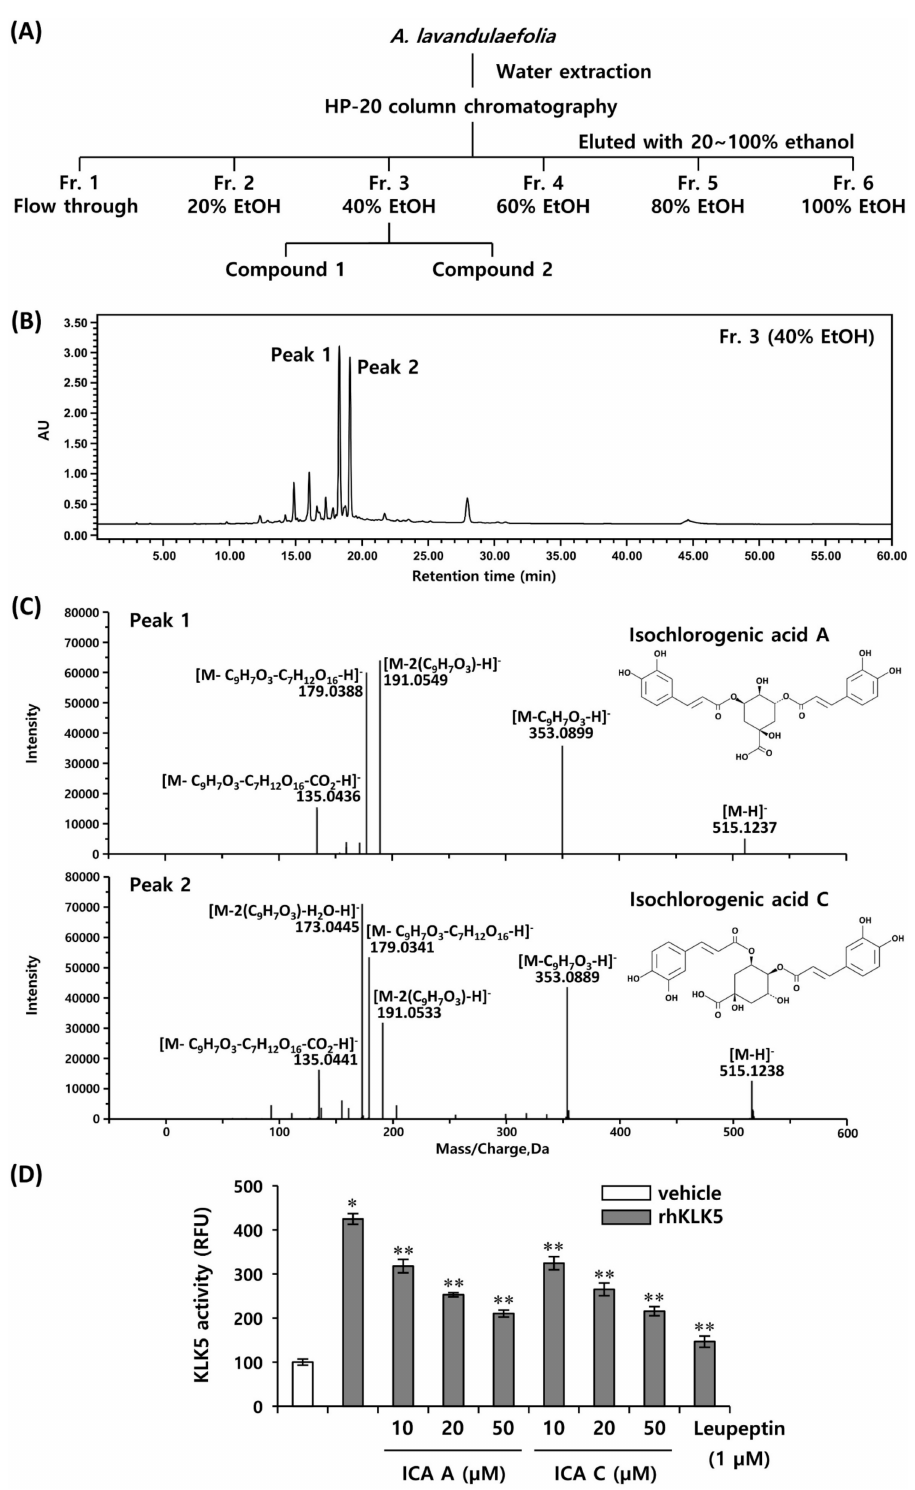
Figure 2. Bioassay-guided isolation and identification of bioactive compounds from A. lavandulaefolia inhibiting KLK5 activity. ( A ) Schematic representation of bioassay-guided isolation of bioactive compounds. ( B ) HPLC chromatogram of fractionation 3. ( C ) Negative ion MS/MS spectra for compounds 1 and 2. ( D ) The inhibitory effect of compounds 1 and 2 on KLK5 activity was measured using Boc-V-P-R-AMC, fluorogenic peptide substrate. The results are expressed as mean ± standard deviation (SD) ( n = 3). * p < 0.01 vs. vehicle control; ** p < 0.01 vs. rhKLK5-treated control. ICA A, isochlorogenic acid A; ICA C, isochlorogenic acid